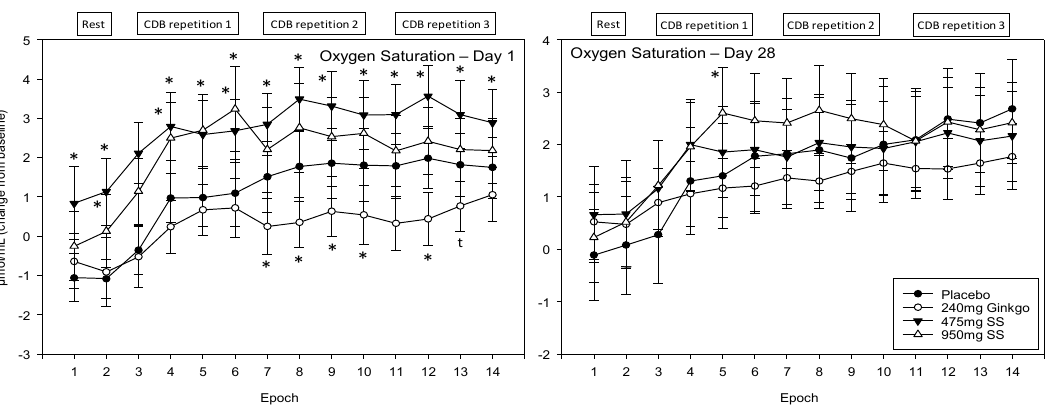
Figure 8. Acute and chronic effects of treatment on oxygen saturation. Mean (±SEM) oxygen saturation concentrations during 5 min of rest (averaged into 2 × 2.5 min epochs) and 30 min (three repetitions) of the cognitive demand battery (CDB). Each 10 min CDB comprises 1 × 2 min epoch of serial 3 and 1 × 2 min epoch of serial 7 subtractions and 2 × 2.5 min epochs of Rapid Visual Information Processing (RVIP). ( left ) Oxygen saturation changes on Day 1; and ( right ) oxygen saturation changes following 28 days of supplementation with 475 mg Sideritis scardica (SS), 950 mg SS, active control (240 mg Ginkgo biloba ) or placebo control. Data on both days were recorded during a ~150–240 min post ‐ dose period and converted from the pre ‐ dose baseline on Day 1. * = p < 0.05.